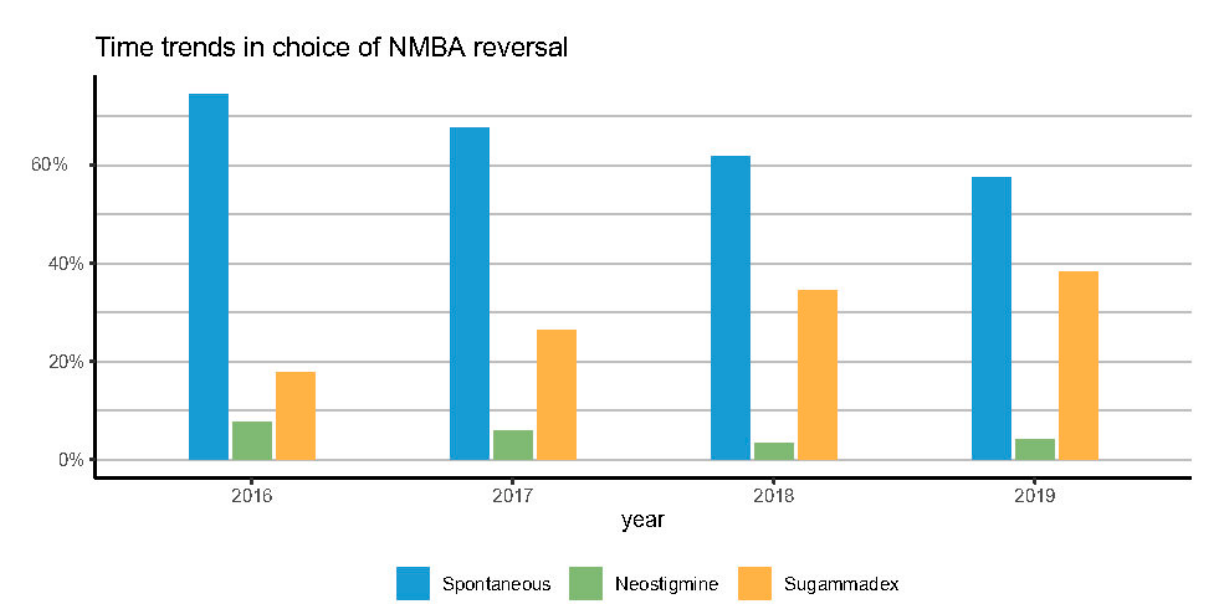
Figure 3. Forest plot of multivariable analysis.